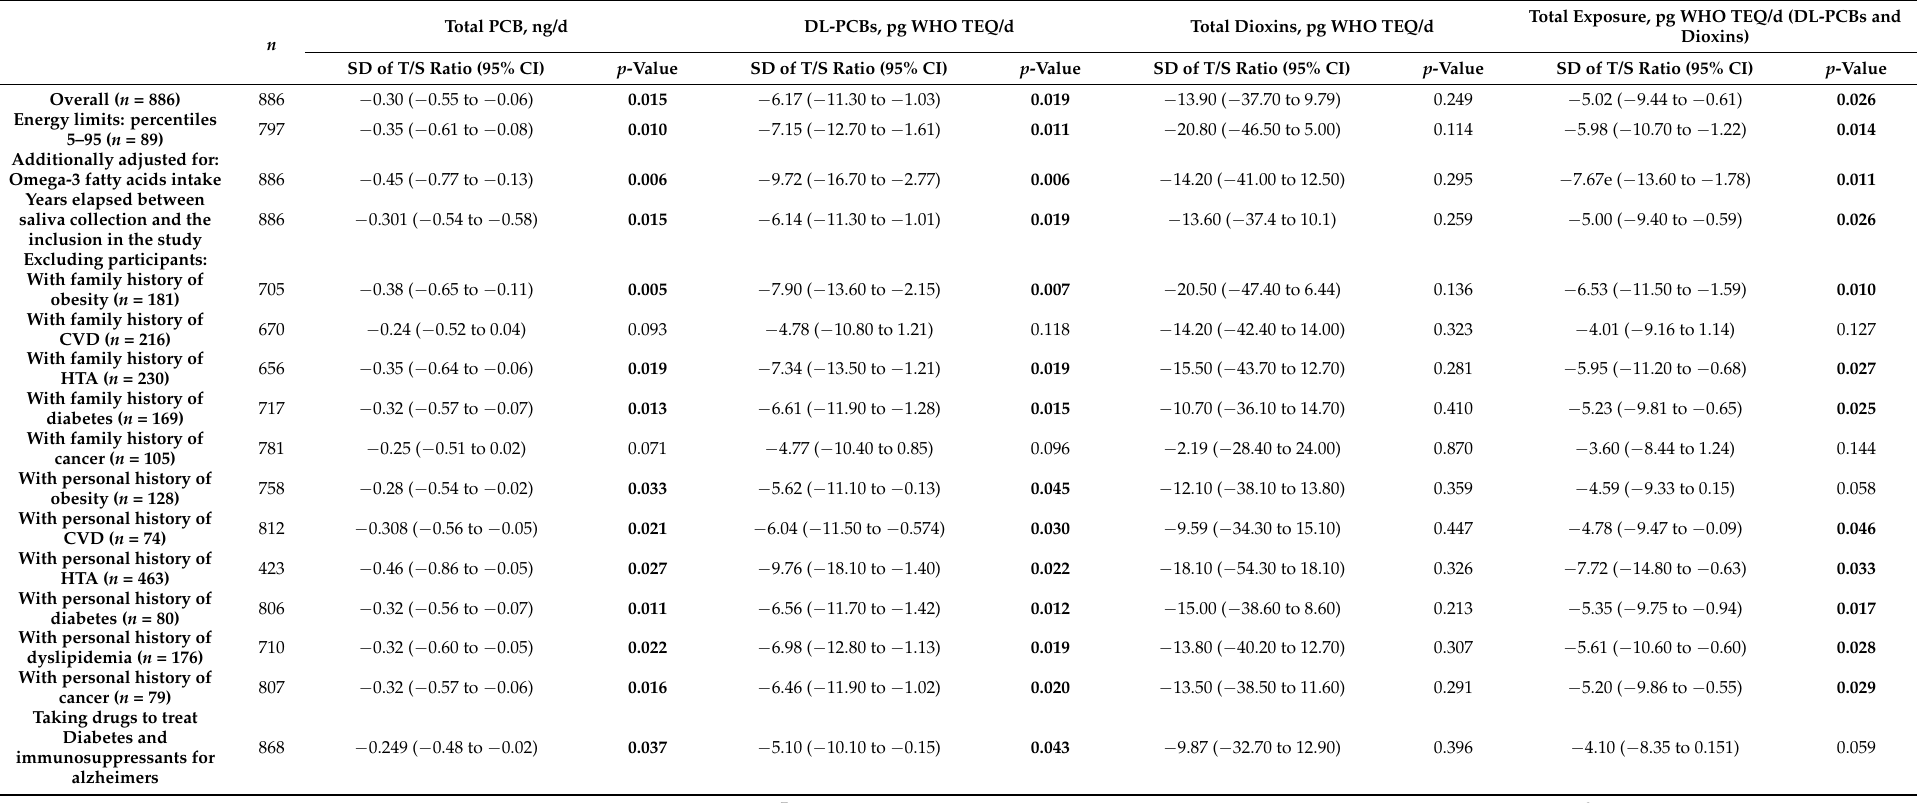
Table 3. Sensitivity analyses for the association between telomere length (SD of T/S ratio) and dietary exposure to PCBs and dioxins energy-adjusted intake of subjects over 55 years from the SUN